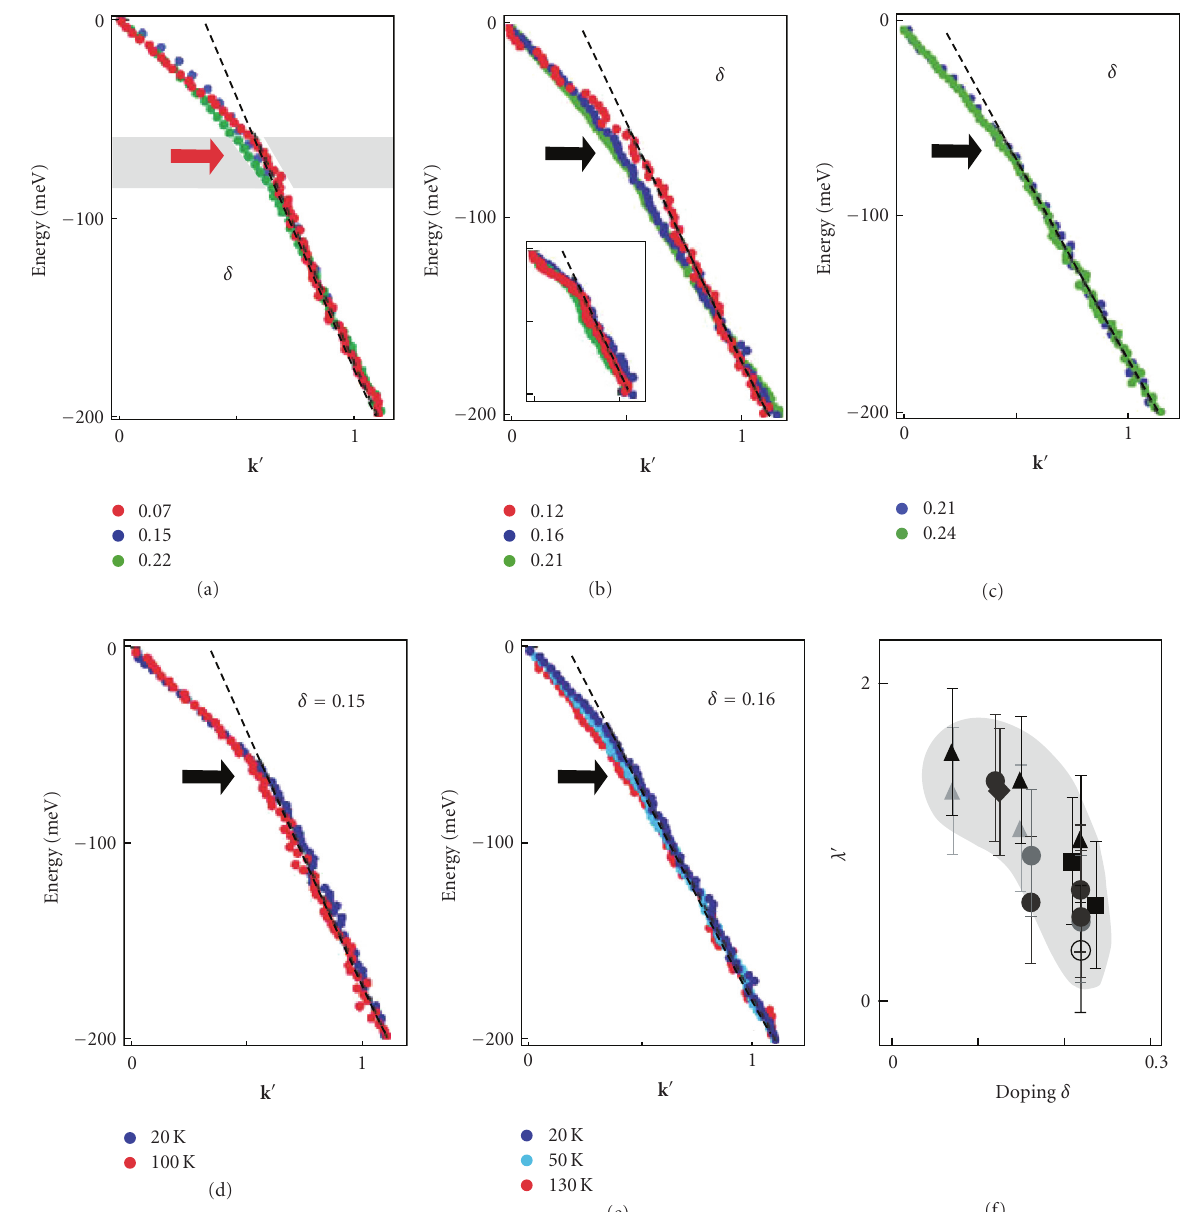
Figure 1: Quasiparticle dispersion in the direction (0,0) − ( π , π ) in the compounds La 2 − x Sr x CuO 4 (LSCO), Bi 2 Sr 2 CuO 6 (Bi2201), and Bi 2 Sr 2 CaCu 2 O 8 (Bi2212) at di ff erent temperatures and dopings. Panel (f) shows the value 1 + λ (cid:2) , evaluated by the change of the dispersion angle in the weak coupling theory for noninteracting electrons in metal, after Lanzara et al.